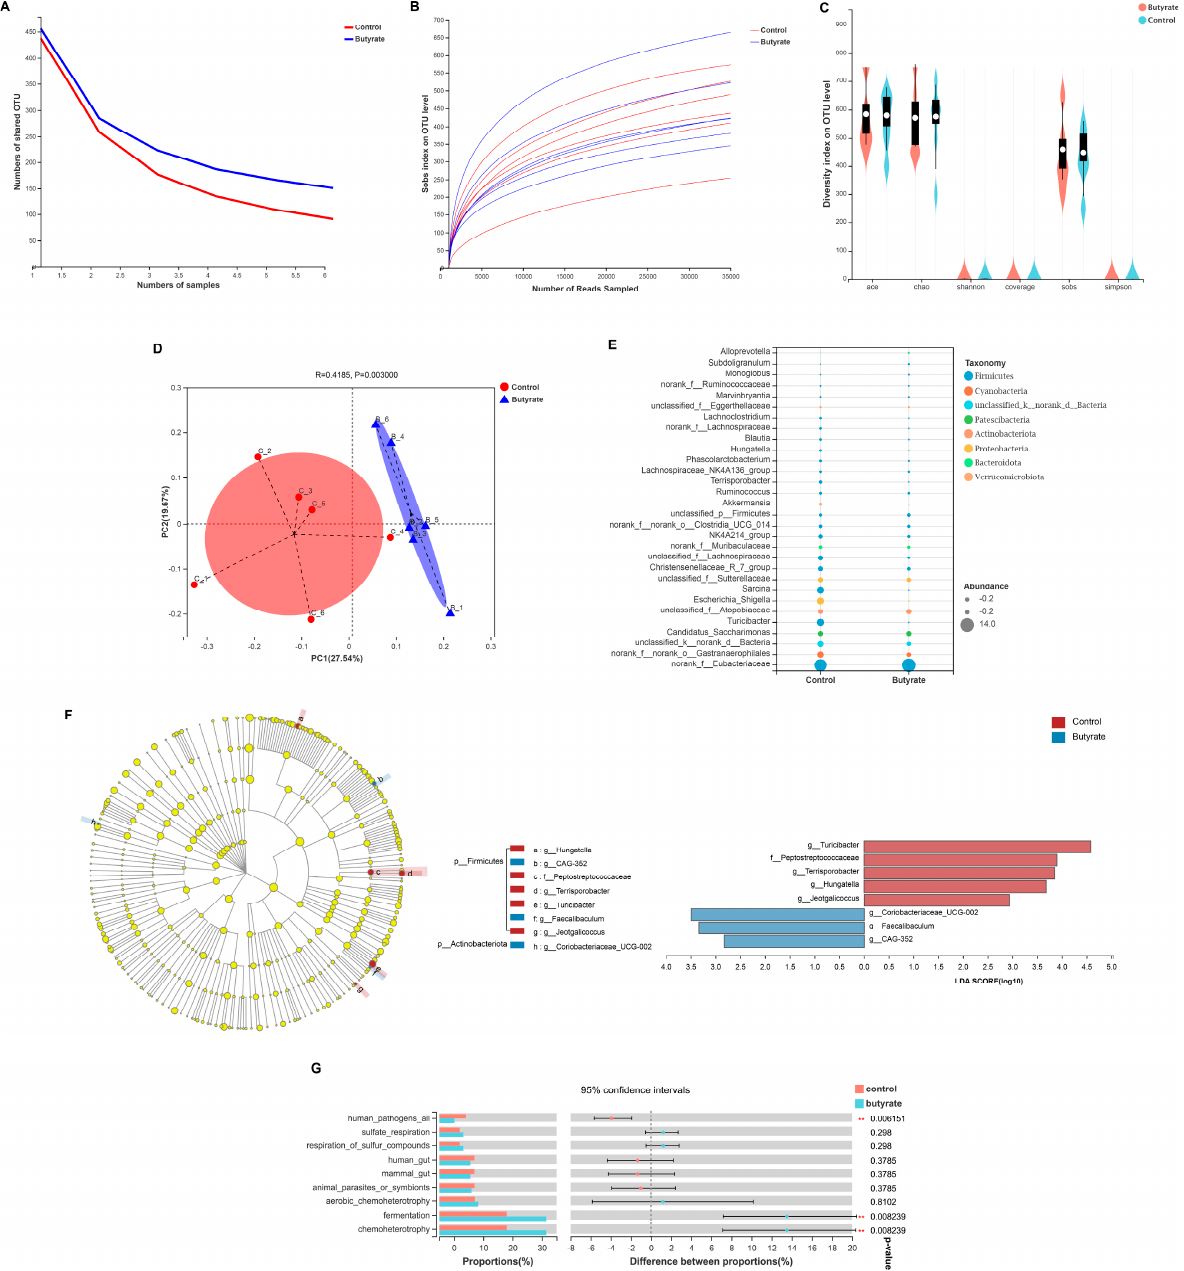
Figure 2. Effect of butyrate on the expression of inflammatory factors and appetite proteins in the ileum, plasma and hypothalamus of weanling rabbits. ( A ) Expression of inflammatory factors in ileal tissues. ( B ) Expression of inflammatory factors in hypothalamic tissue. ( C ) Expression of inflammatory factors in plasma. ( D ) Expression levels of appetite regulation related brain–gut hormones in the ileum. ( E ) Expression levels of brain–gut hormones associated with appetite regulation in plasma. ( F ) Expression levels of proteins associated with appetite regulation in the hypothalamus. Date are expressed as mean ± SEM, n = 6, * p < 0.05 (Western blots for each set of reference protein and target protein were from one blot, and the black line represents the cropped edge of the blot).